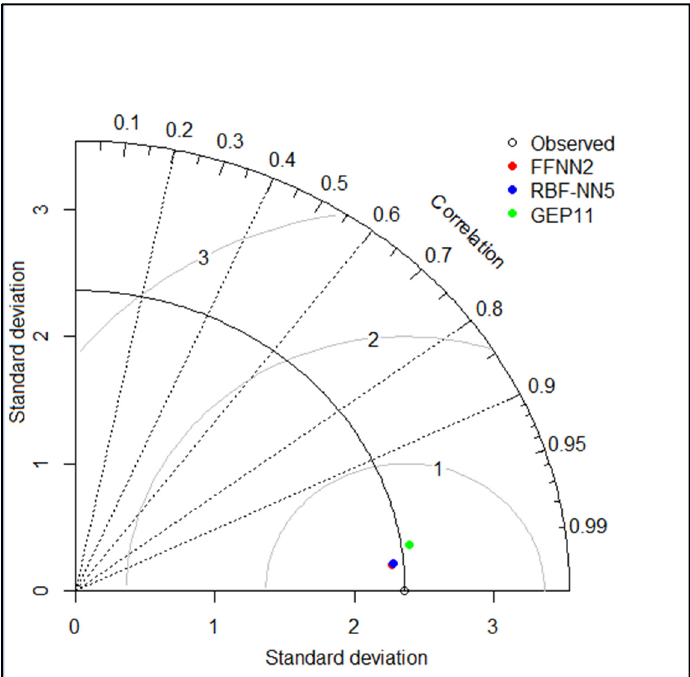
Figure 10. Taylor diagram for best performing models.